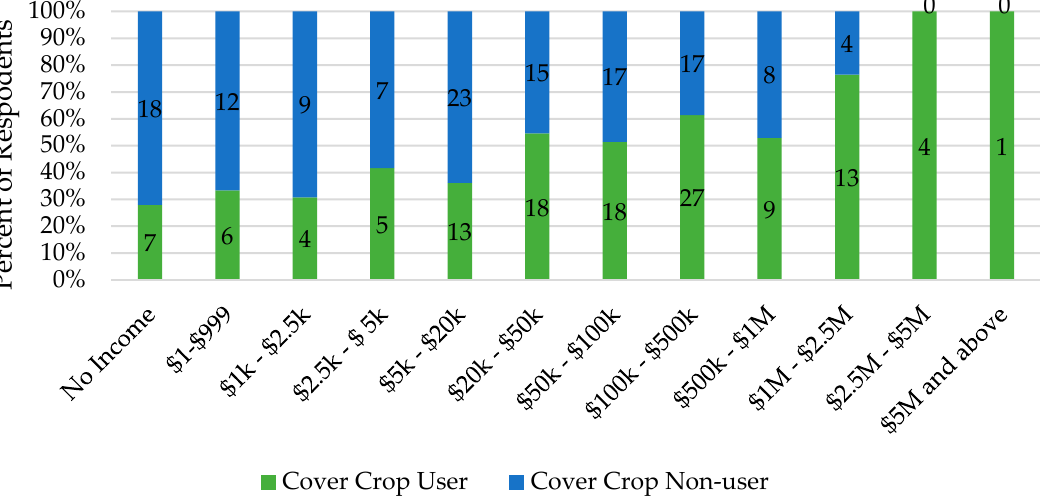
Figure 8. Income distribution of cover crop users and non-users; respondent count is indicated in each bar.